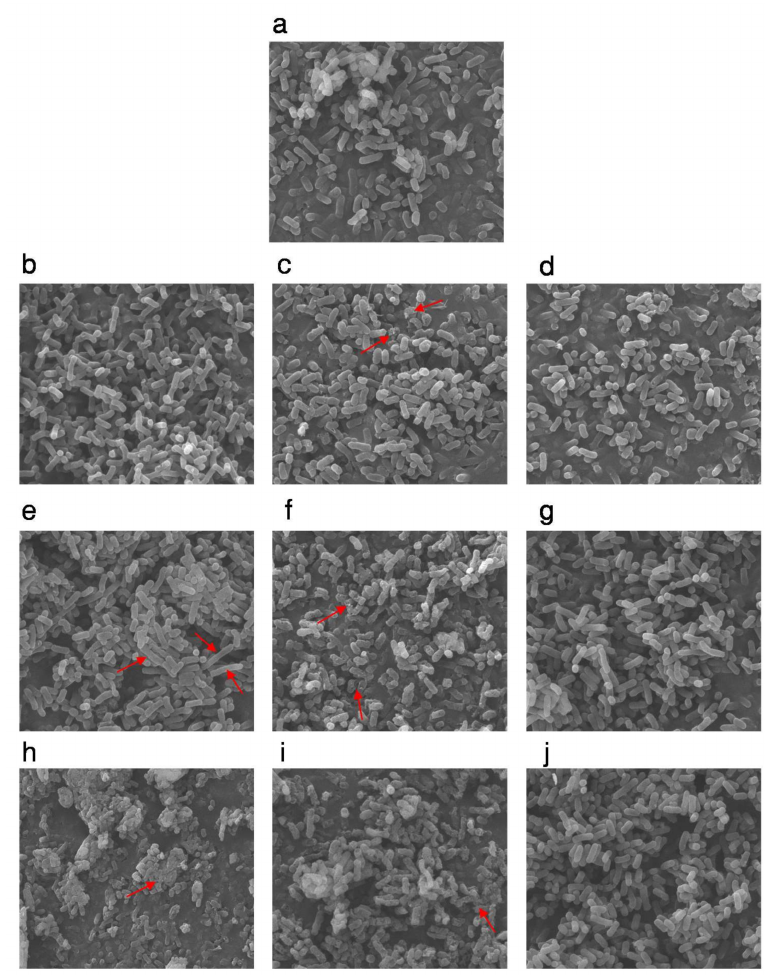
Figure 2. The scanning electron microscopy (SEM) images of di ff erently packed E. coli before and after di ff erent pressure treatments. Untreated E. coli cells ( a ); vacuum-packed ( b ), CO 2 -packed ( c ), and N 2 -packed ( d ) E. coli cells after high hydrostatic pressure (HHP) treatment at 250 MPa: Vacuum-packed ( e ), CO 2 -packed ( f ) and N 2 -packed ( g ) E. coli cells after HHP treatment at 350 MPa; Vacuum-packed ( h ), CO 2 -packed ( i ) and N 2 -packed ( j ) E. coli cells after HHP treatment at 450 MPa. Red arrows represent the remarkable